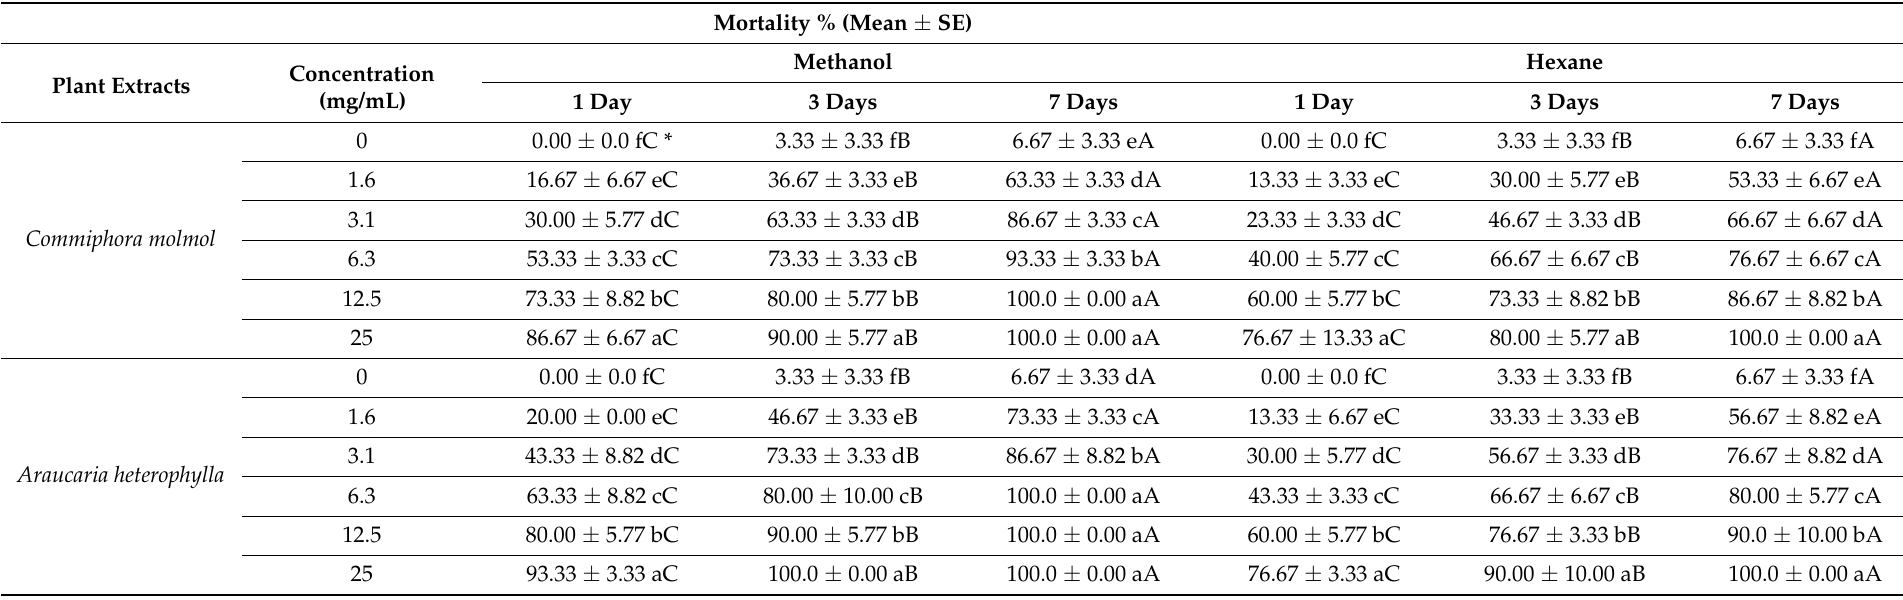
Table 1. The efficacy of the plant extracts of Commiphora molmol and Araucaria heterophylla against the Camel tick, Hyalomma dromedarii . Mortality % (Mean ± SE) Plant